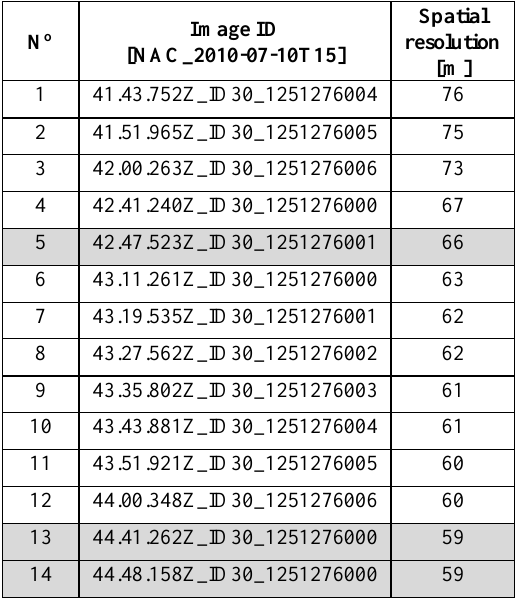
Table 1. Input dataset (the training dataset is presented with a